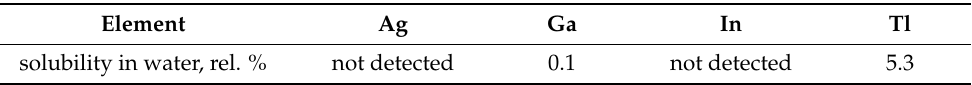
Table 4. Percentage of water-soluble forms of silver, gallium, indium and thallium in